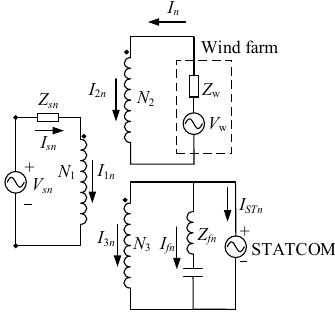
Figure 7. The single ‐ phase equivalent ‐ circuit model of the new grid ‐ connected transformer with fully ‐ tuned (FT) branches.